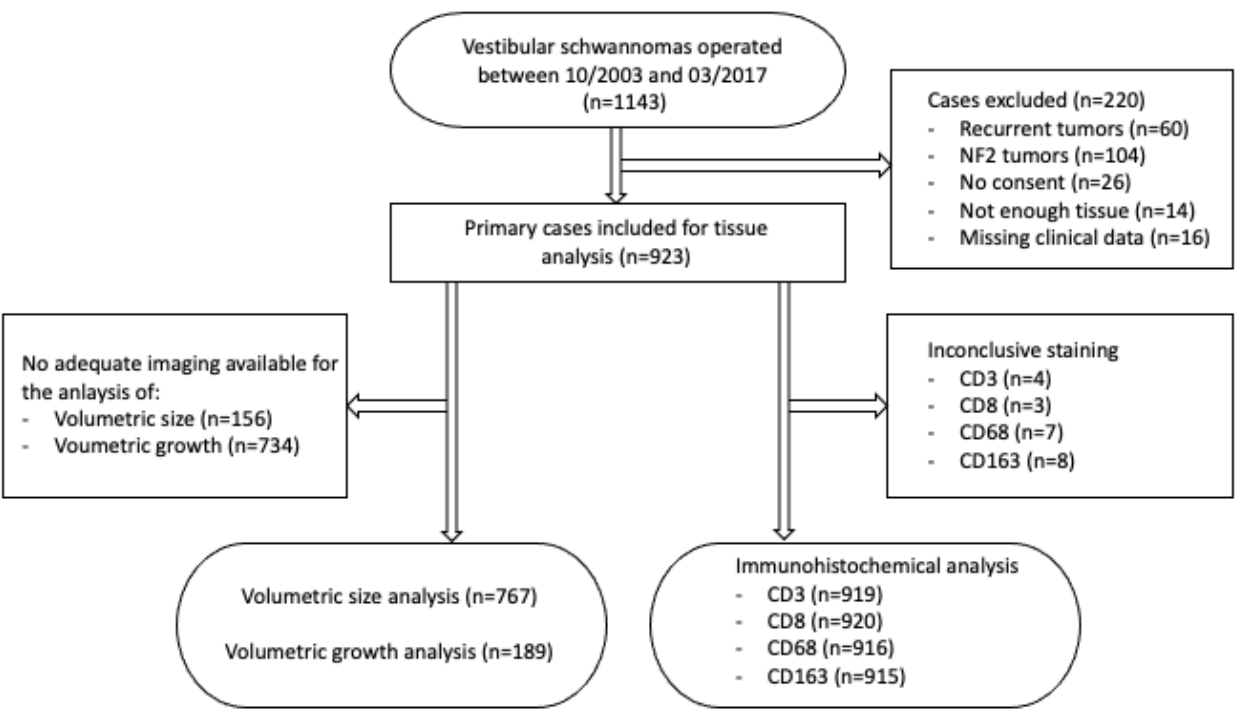
Figure 6. Consort diagram showing the cases included and excluded in this study.